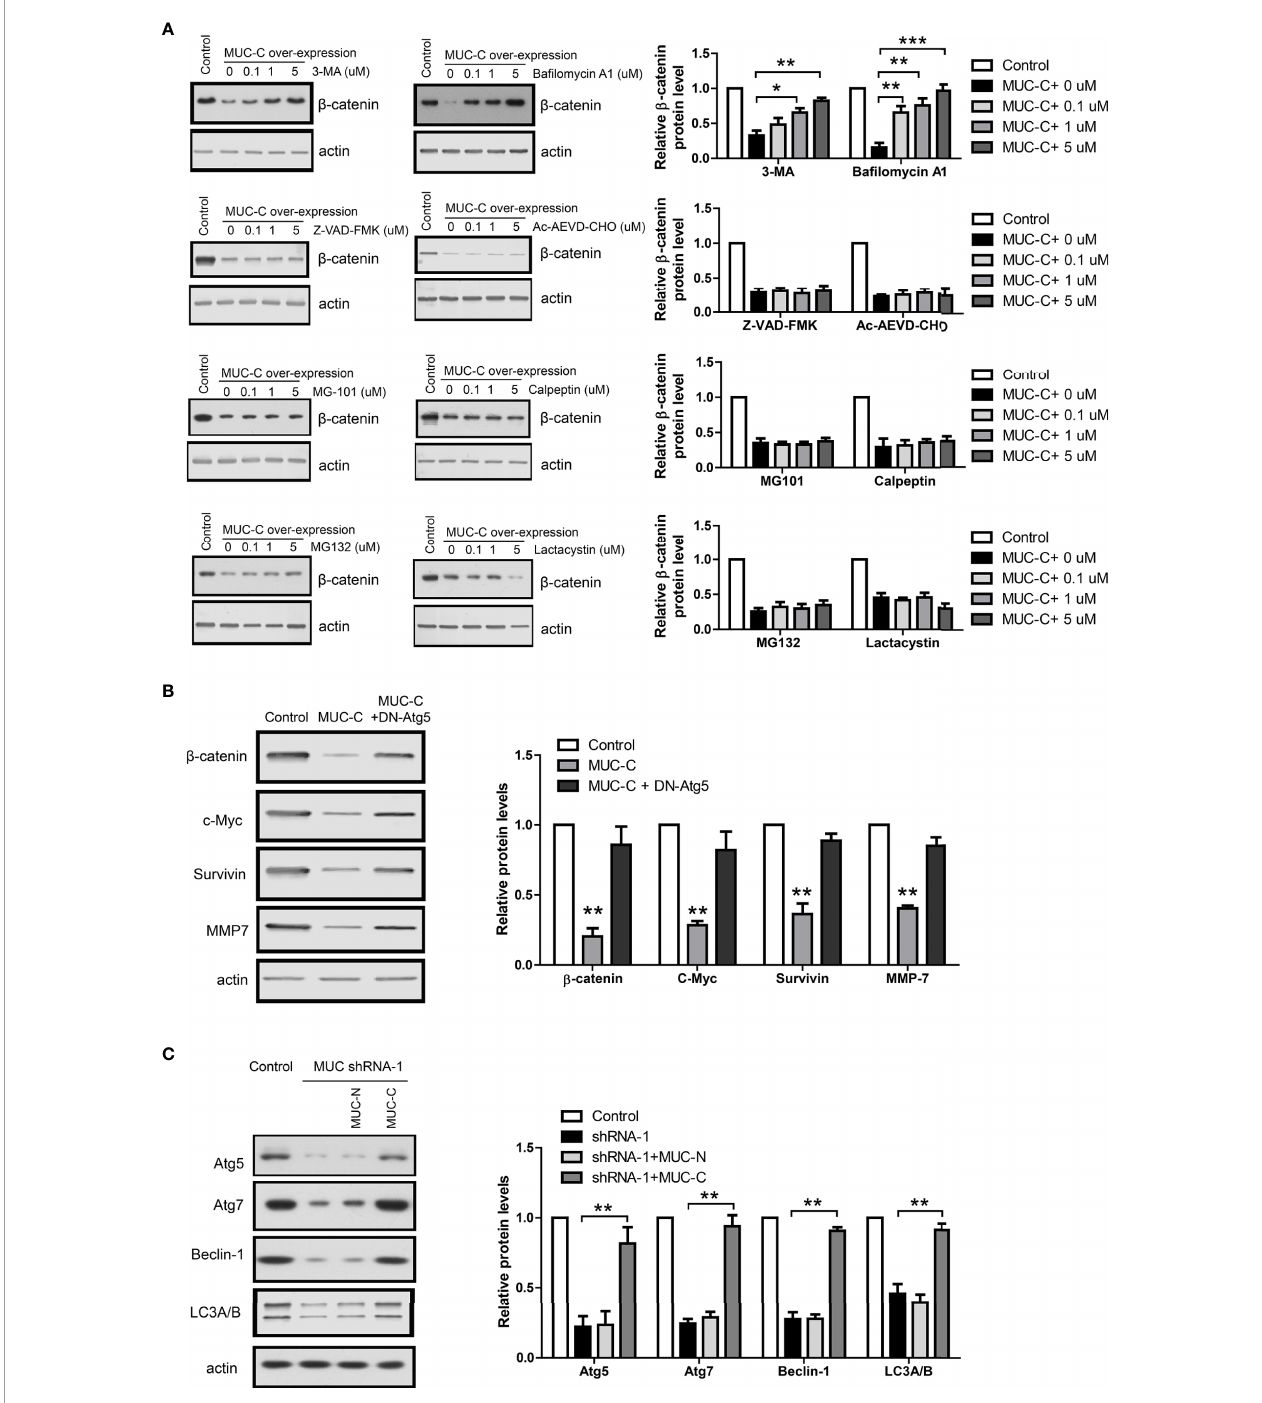
FIGURE 5 | Autophagy pathway mediates MUC6-induced b -catenin degradation in WT cell. (A) Immunoblots showing b -catenin protein levels in WiT49 cell treated with Z-VAD-FMK, Ac-AEVD-CHO, MG-101, Calpeptin, MG132, Lactacystin, 3-MA or Ba fi lomycin A1 at indicated concentrations. (B) Immunoblots showing b -catenin protein levels in WiT49 cell infected with MUC-C alone or with dominant negative Atg5 together. (C) Immunoblots showing the effects of MUC-N or MUC-C over-expression on Atg5, Atg7, Beclin-1 and LC3A/B protein levels in WiT49 cell infected with MUC shRNA-1. For all, *P<0.05; **P<0.01;